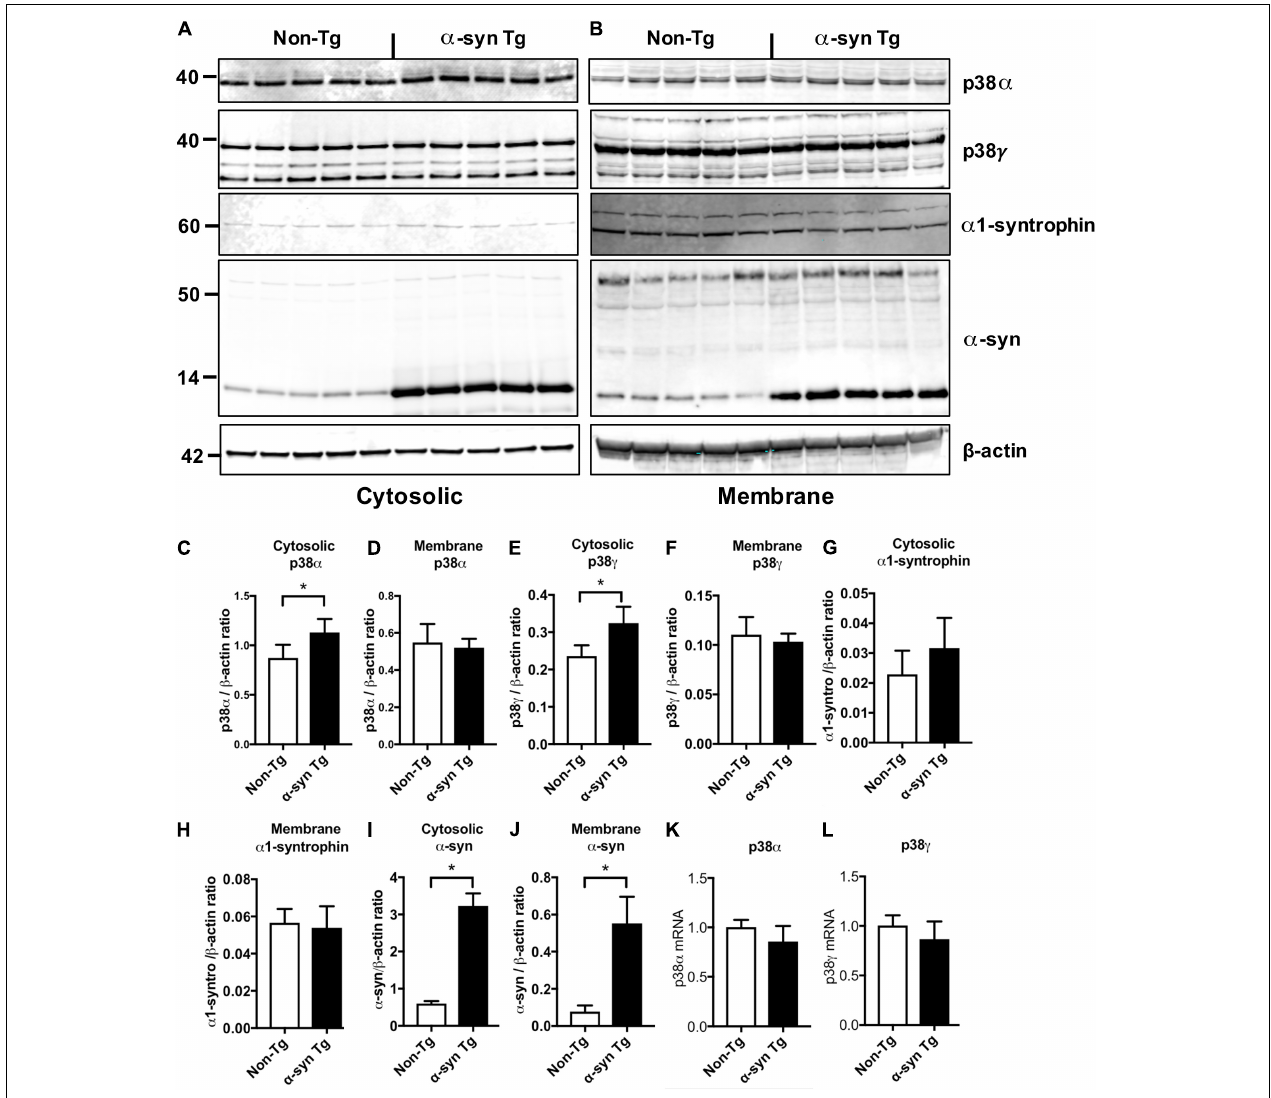
FIGURE 6 | Immunoblot and RNA analysis in non-Tg and α -syn Tg mouse brains. Mouse hemibrains were separated into cytosolic and membrane fractions by extracting sequentially with Tris and PDGF buffer and probed with p38 α , p38 γ , α 1-syntrophin, α -syn, and β -actin. (A,B) Representative immunoblot images for (A) cytosolic and (B) membrane fractions probed with p38 α , p38 γ , α 1-syntrophin, α -synuclein, and β -actin. In each panel, left five lanes show non-Tg mice and right lanes show α -syn Tg mice. (C,D) Image analysis of cytosolic and membrane fractions probed for p38 α , respectively; (E,F) image analysis of cytosolic and membrane fractions probed for p38 γ , respectively; (G,H) image analysis of cytosolic and membrane fractions probed for α -1 syntrophin, respectively (I,J) image analysis of cytosolic and membrane fractions probed for α -synuclein, respectively; (K , L) real time quantitative PCR analysis showed no significant differences in p38 α (K) and p38 γ (L) RNA expression between non-Tg and α -syn Tg mice. n = 5 per group (* p <